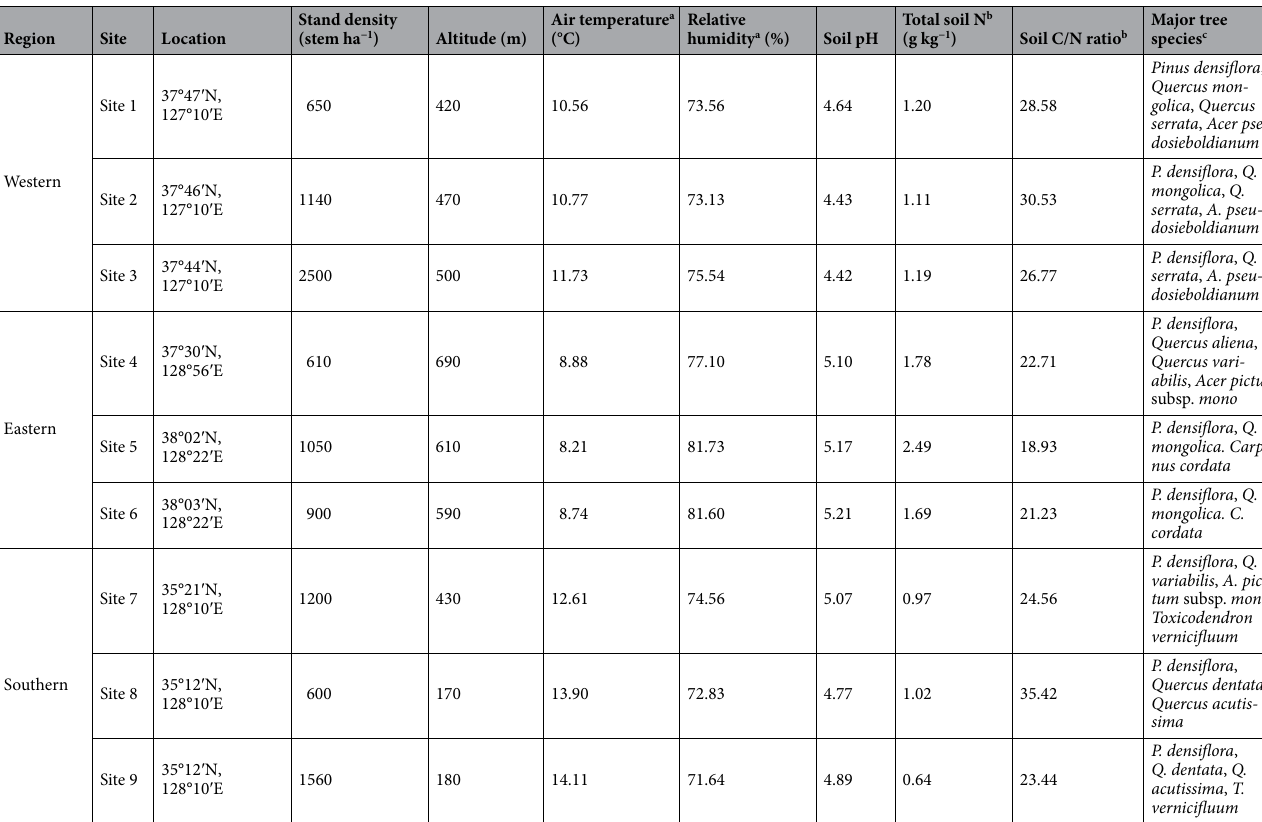
Table 2. Environmental conditions in the study sites in the western, eastern, and southern regions. a The average annual values during the study period (24 months). b Total soil N: total soil nitrogen; soil C/N ratio: soil carbon-to-nitrogen ratio. c Tree species dominating canopy and sub-canopy